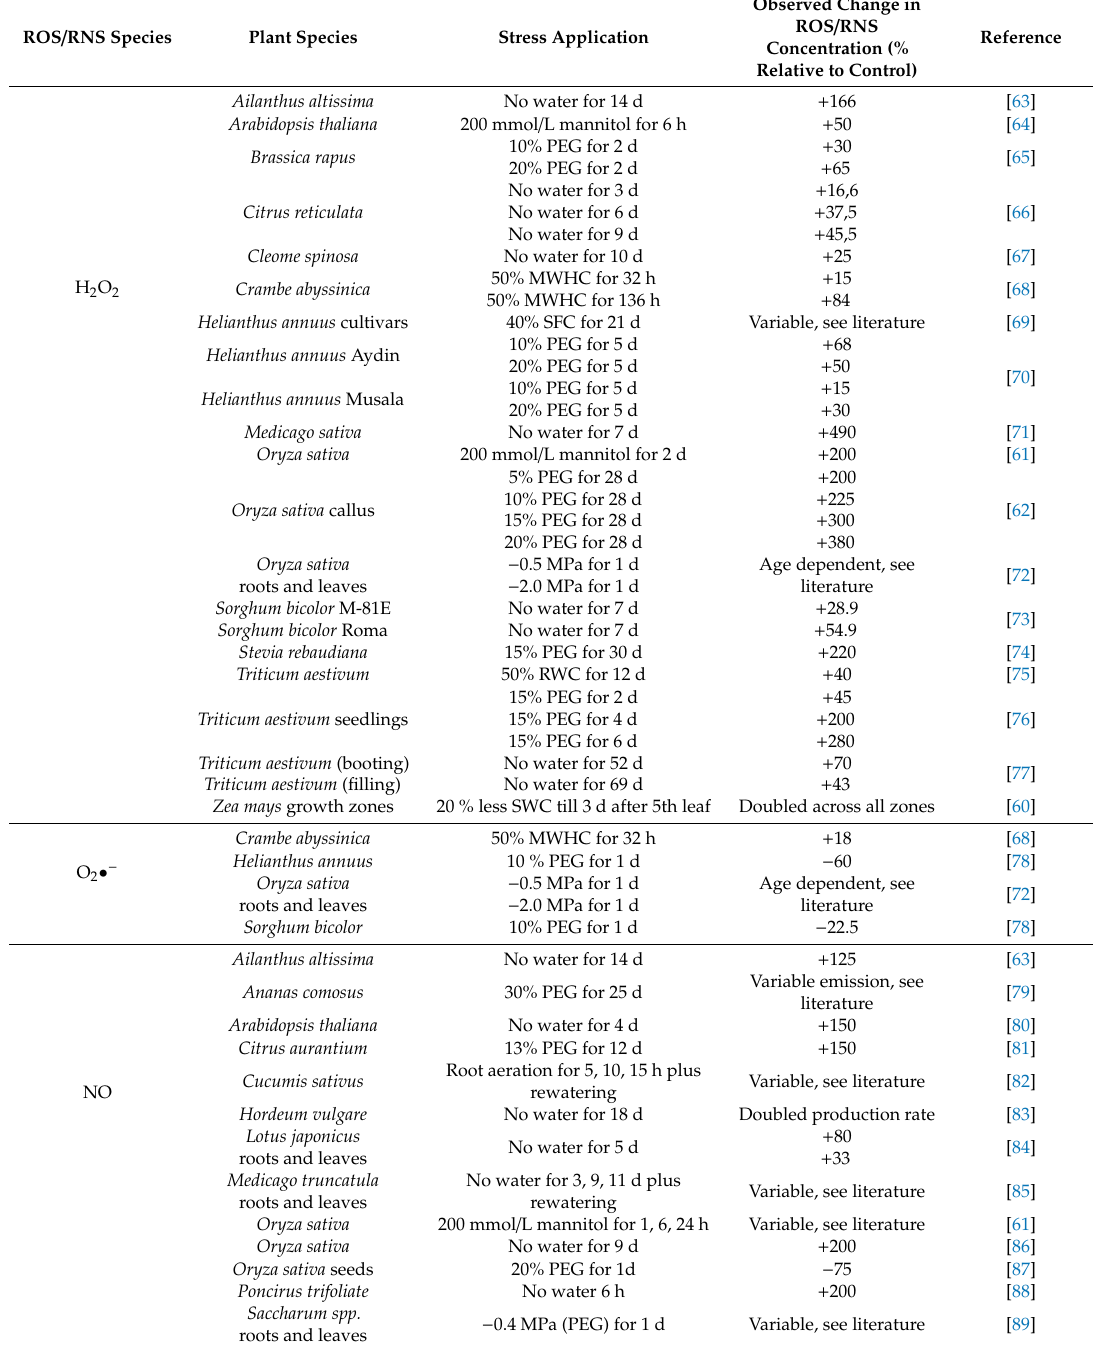
Table 3. Changes in reactive oxygen species (ROS) and nitric oxide (NO) amounts upon drought or osmotic stress treatment in various plant species. Data originate from green leaf tissue if not indicated otherwise. Increase in percent was chosen due to di ff erent detection methods with di ff erent units. E ff ects were estimated from graphs, figures and tables if not directly given in the text or